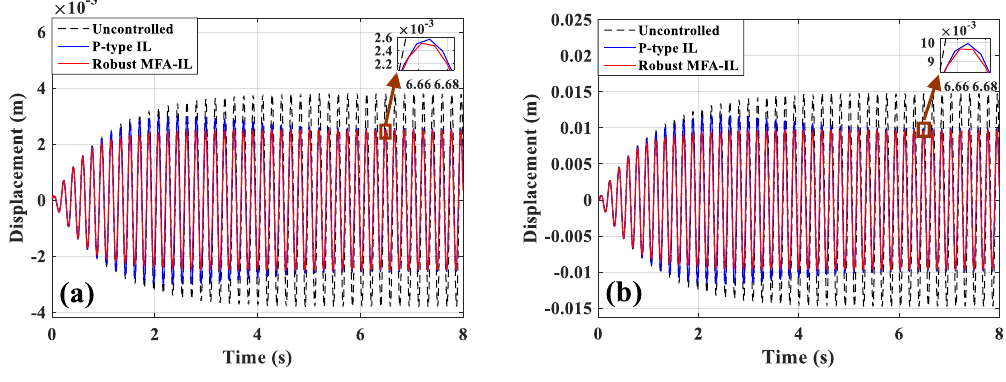
Figure 4. Displacement responses: ( a ) Point A, ( b ) point B .